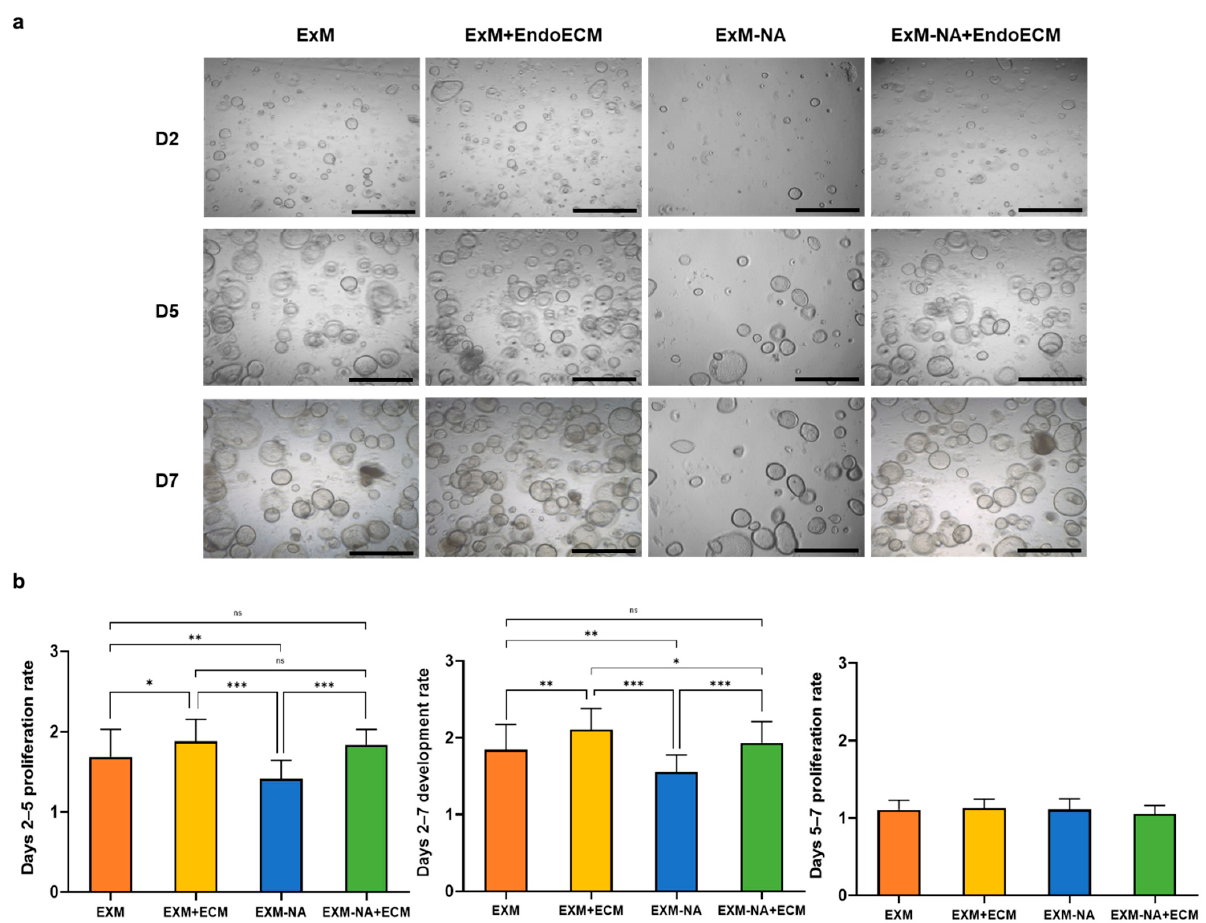
Figure 5. Comparative proliferation of human endometrial organoids exposed to different conditions. ( a ) Representative images of endometrial organoids in all culture conditions: ExM, ExM+EndoECM, ExM-NA, ExM-NA+EndoECM. ( b ) Days 2–7, 2–5, and 5–7 proliferation rates. * p < 0.05, ** p < 0.001, *** p < 0.0001. Scale bars are 1 mm.